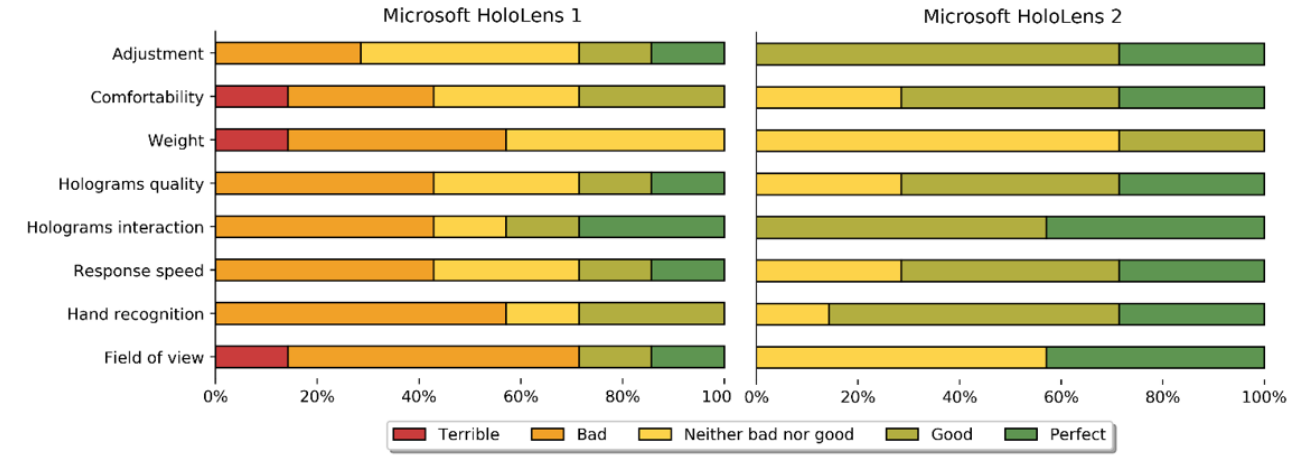
Figure 6. Survey responses regarding Microsoft HoloLens 1 and Microsoft HoloLens 2.